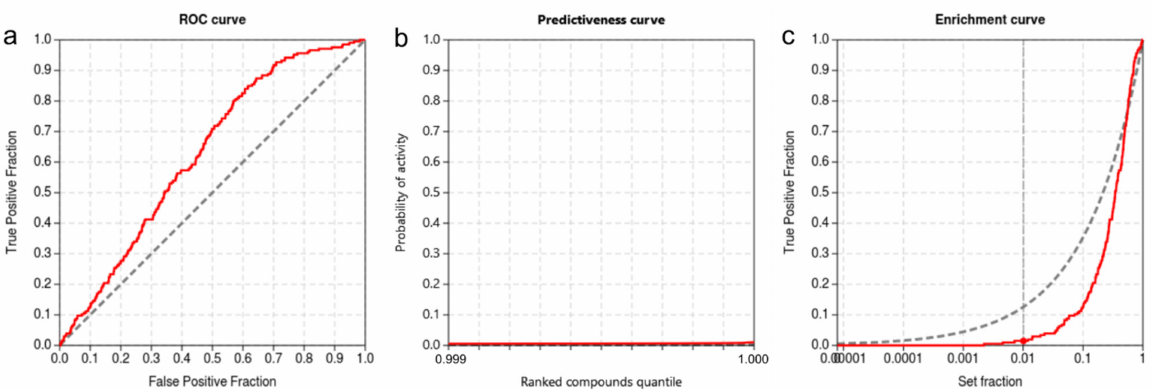
Figure 15. Validation of the inverse molecular docking protocol using rosmarinic acid: ( a ) the ROC curve, with the ROC AUC of 0.627; ( b ) predictiveness curve, from which the TG of 0.171 is determined; ( c ) enrichment